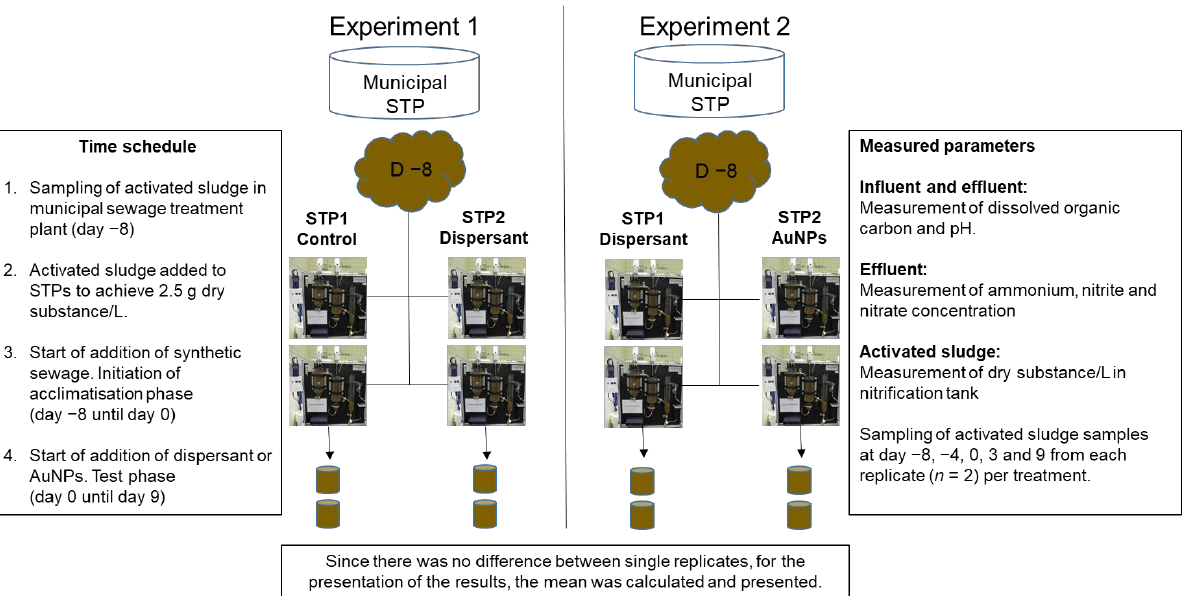
Figure 1. Schematic representation of the temporal sequence and the measurements carried out in the two experiments (experiment 1: control vs. dispersant and experiment 2: dispersant vs. AuNPs).